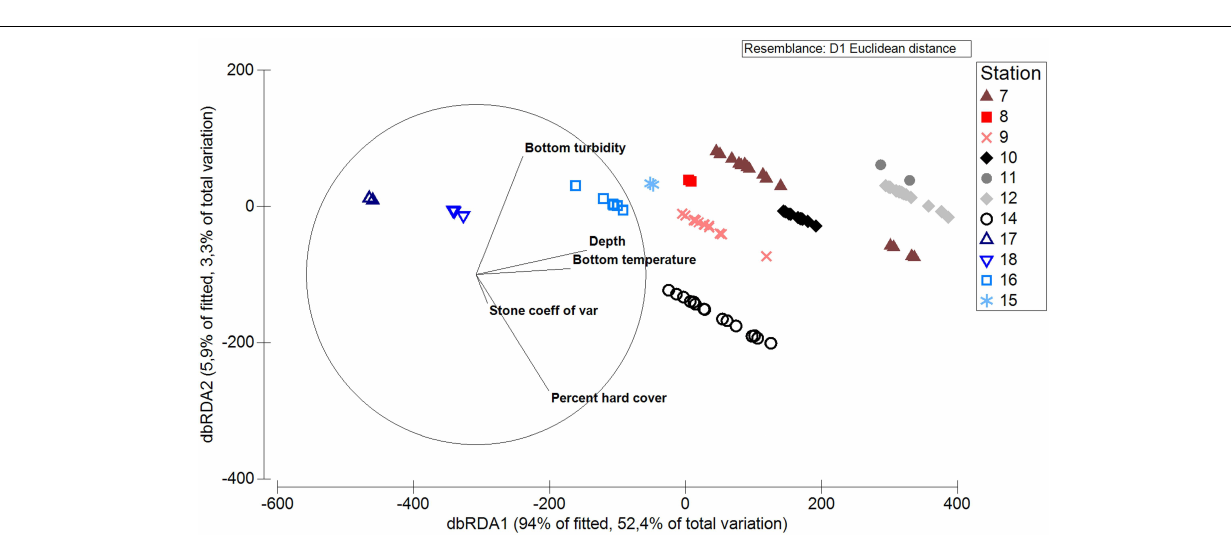
(Grange and Smith, 2013). Antarctic fjords are hypothesized